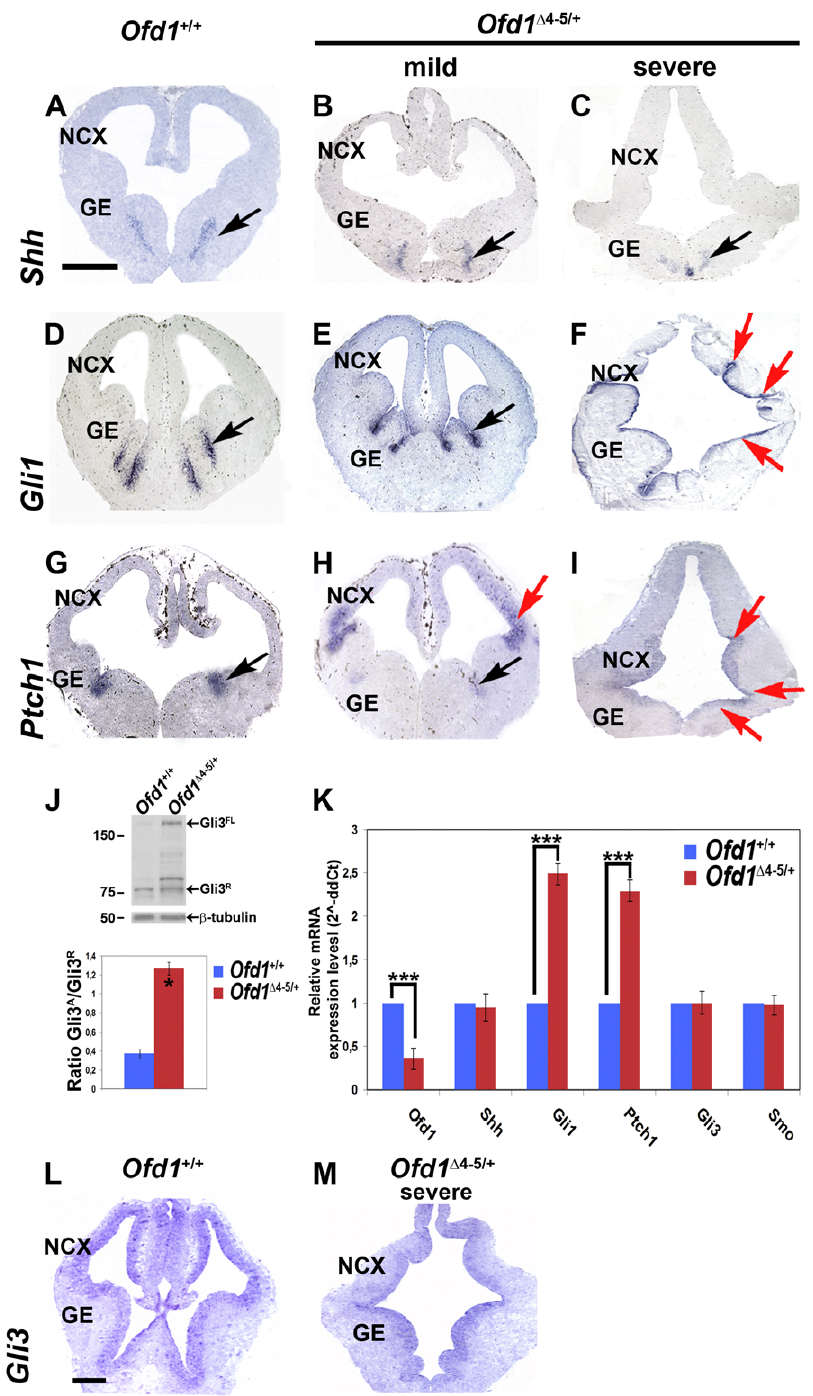
Figure 4. Shh signalling is altered in the developing forebrain of Ofd1 D 4–5/ + embryos. ISH showed a normal expression pattern of Shh in Ofd1 D 4–5/ + heterozygous females (black arrows in B, C) when compared to Ofd1 + / + wild-type embryos (black arrow in A). Gli1 displays an ectopic expression in the neocortex in mutants with a severe phenotype (red arrows in F) while it is confined to the ventral part in Ofd1 + / + wild-type embryos (black arrow in D) and Ofd1 D 4–5/ + heterozygous females with a mild phenotype (black arrow in E). Ptch1 expression is upregulated in the neocortex in both mutants with a mild (red arrow in H) and severe phenotype (red arrows in I). Dorsal is upwards, ventral is downwards. Scale bars: 200 m m. NCX: neocortex. GE: ganglionic eminences. Western blot analysis of Gli3 protein on E12.5 Ofd1 + / + wild-type and Ofd1 D 4–5/ + heterozygous brains with a severe phenotype. An increase level of the larger isoform 190 kDa Gli3 FL isoform is observed in Ofd1 mutant animals when compared to controls, thus indicating an impairment during Gli3 processing (J). Quantification of the ratio of Gli3 FL versus Gli3 R indicates a 3.4-fold increase in the mutant animals (J). Asterisk (*) denotes statistically significant changes with p , 0.05. Quantitative RT-PCR is performed upon mRNA extraction from E12.5 total brain (K; *** p , 0.01). Error bars indicate standard error of the mean. ISH analysis showed that no difference in Gli3 mRNA expression pattern was observed in Ofd1 D 4–5/ + heterozygous females with a severe phenotype (M) when compared to Ofd1 + / + wild-type embryos (L). Dorsal is upwards, ventral is downwards. Scale bars: 100 m m. NCX: neocortex. GE: ganglionic eminences. doi:10.1371/journal.pone.0052937.g004 PLOS ONE |